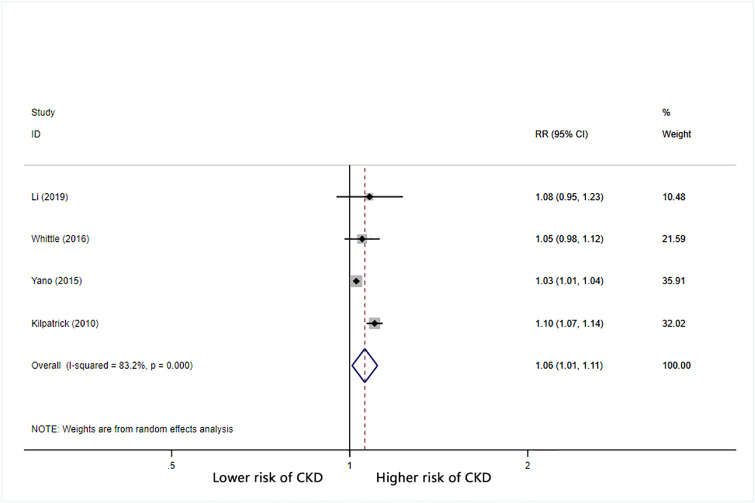
Forest plot of relationship between 1 mmHg increment in SD-DBP and risk of CKD.Boxes represent the Relative risk (RR) and lines represent the 95% Confidence Intervals (CIs) for individual studies. The area of each square is proportional to study weight. The diamonds and their width represent the pooled RRs and the 95% CIs, respectively.